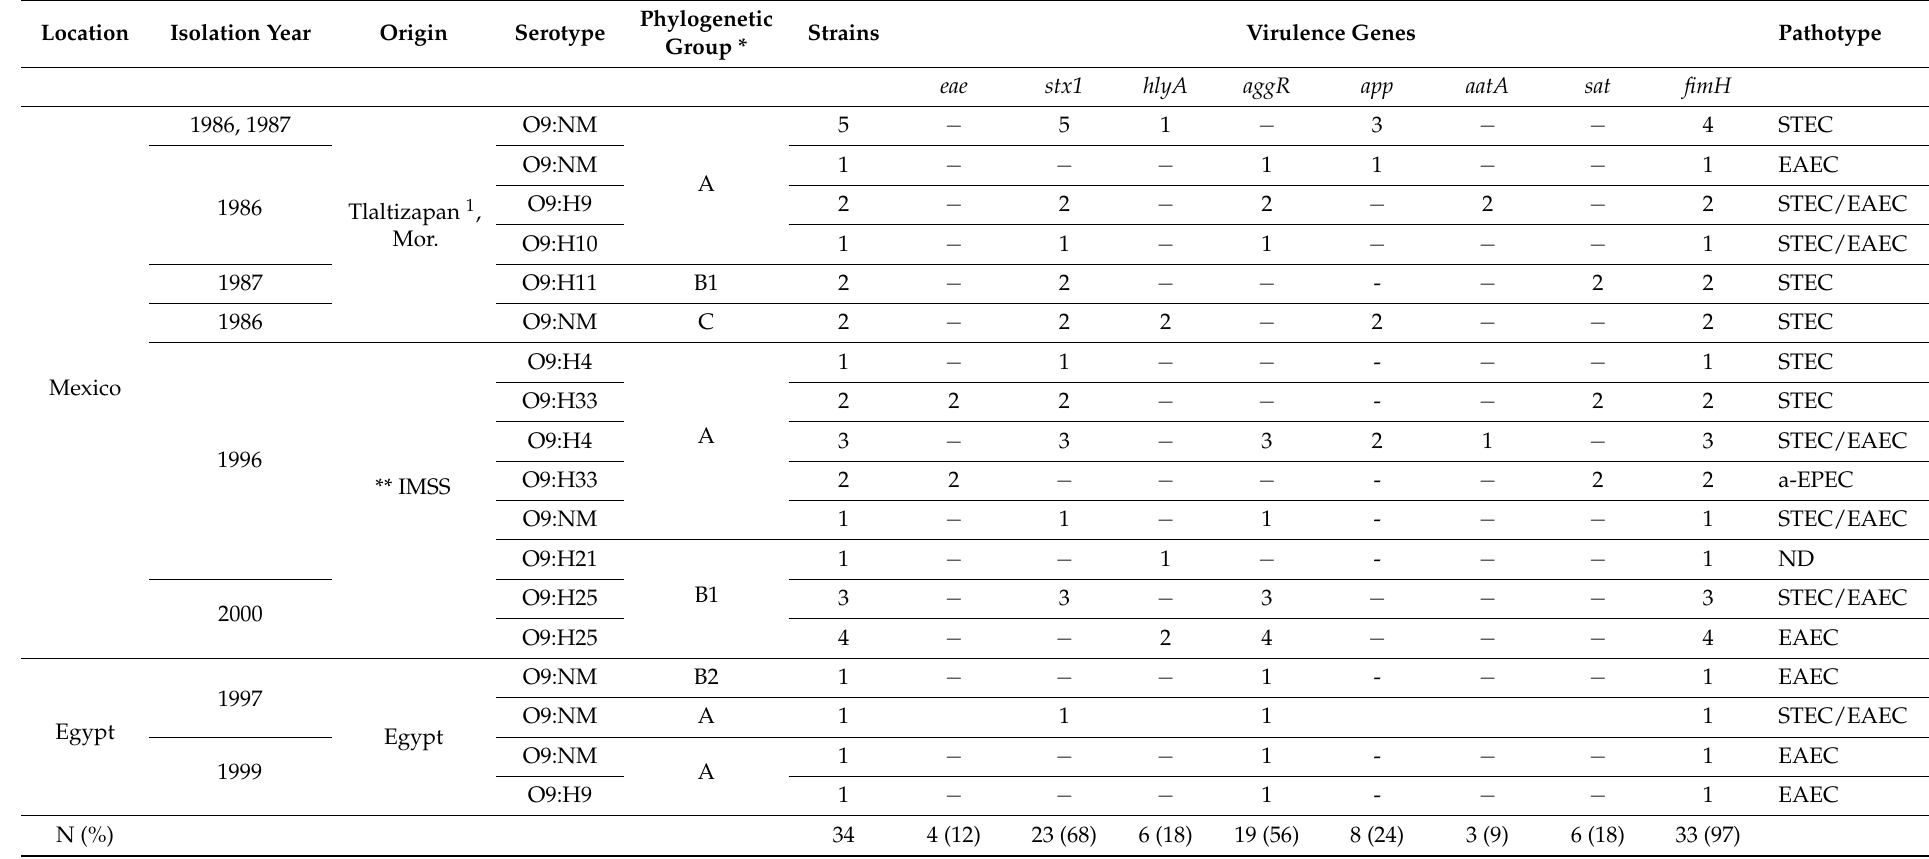
Table 3. Diversity of diarrheagenic groups in E . coli O9